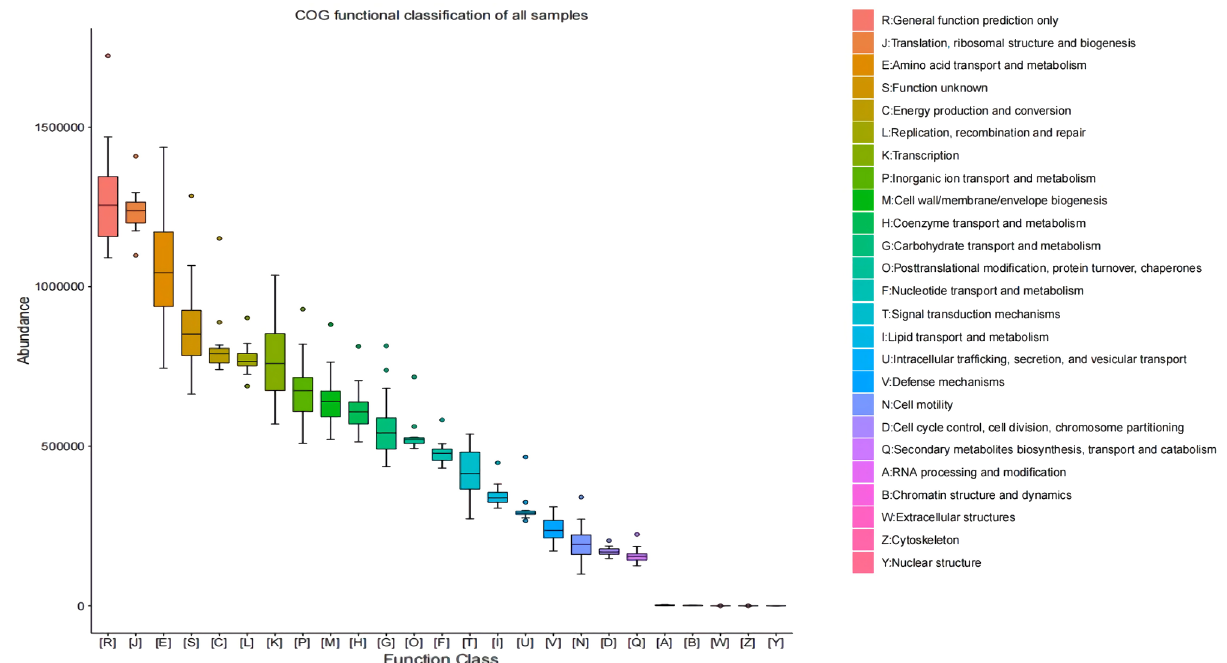
Figure 5. COG functional secondary classification of all the samples. Different colors represent the various functions.